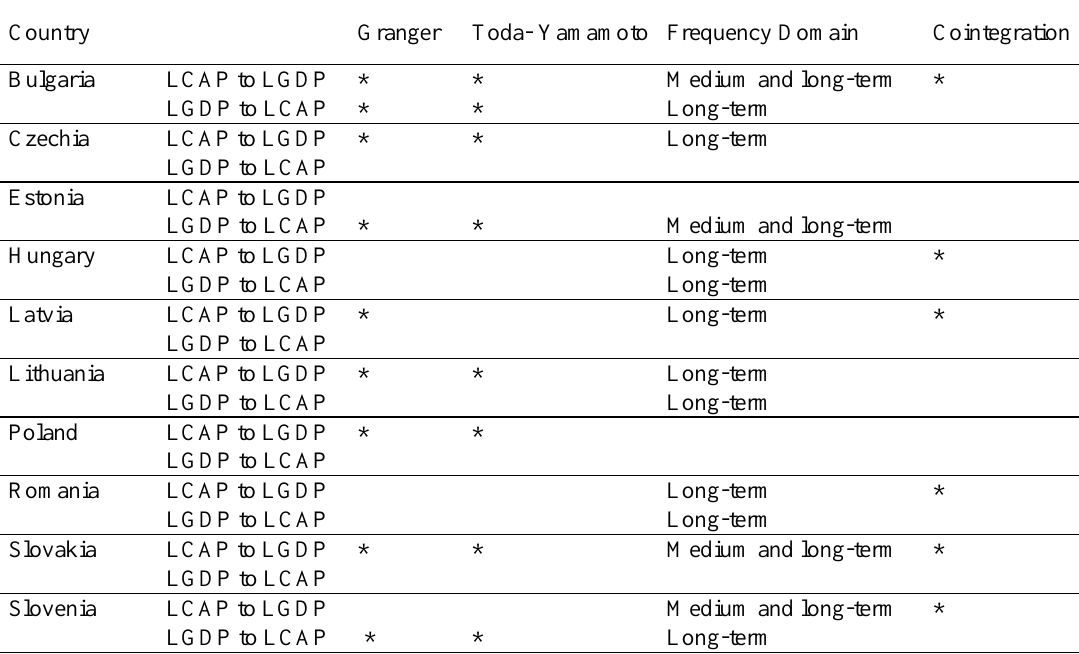
Table 7. Summary of